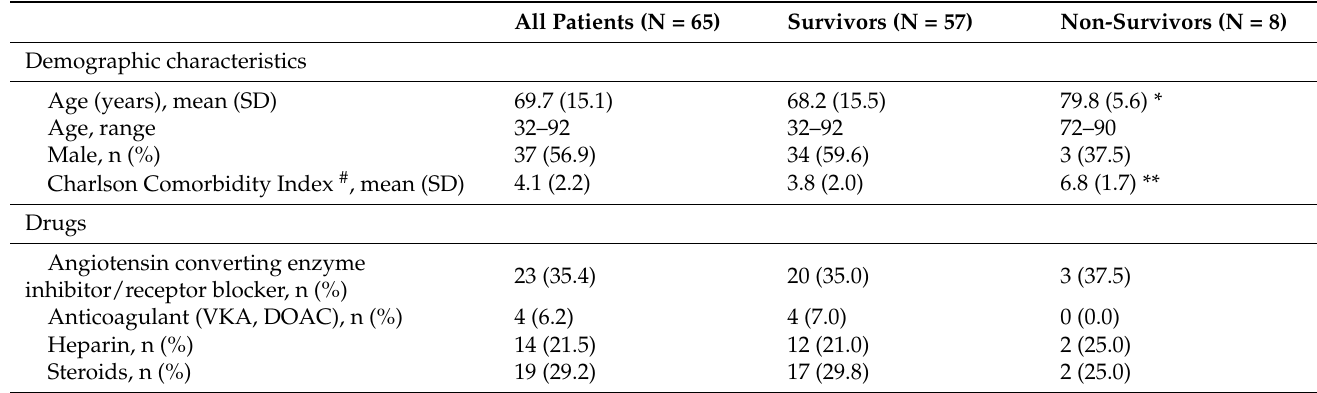
Table 2. Characteristics of patients on admission.